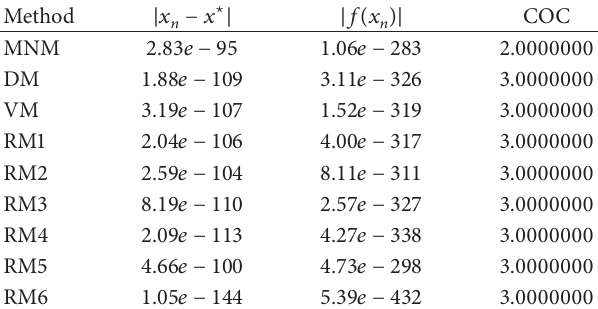
Table 2: Comparison of various iterative methods for the function (𝑥) under the same total number of function evaluations (TNFE) 𝑓 2 required by all methods.